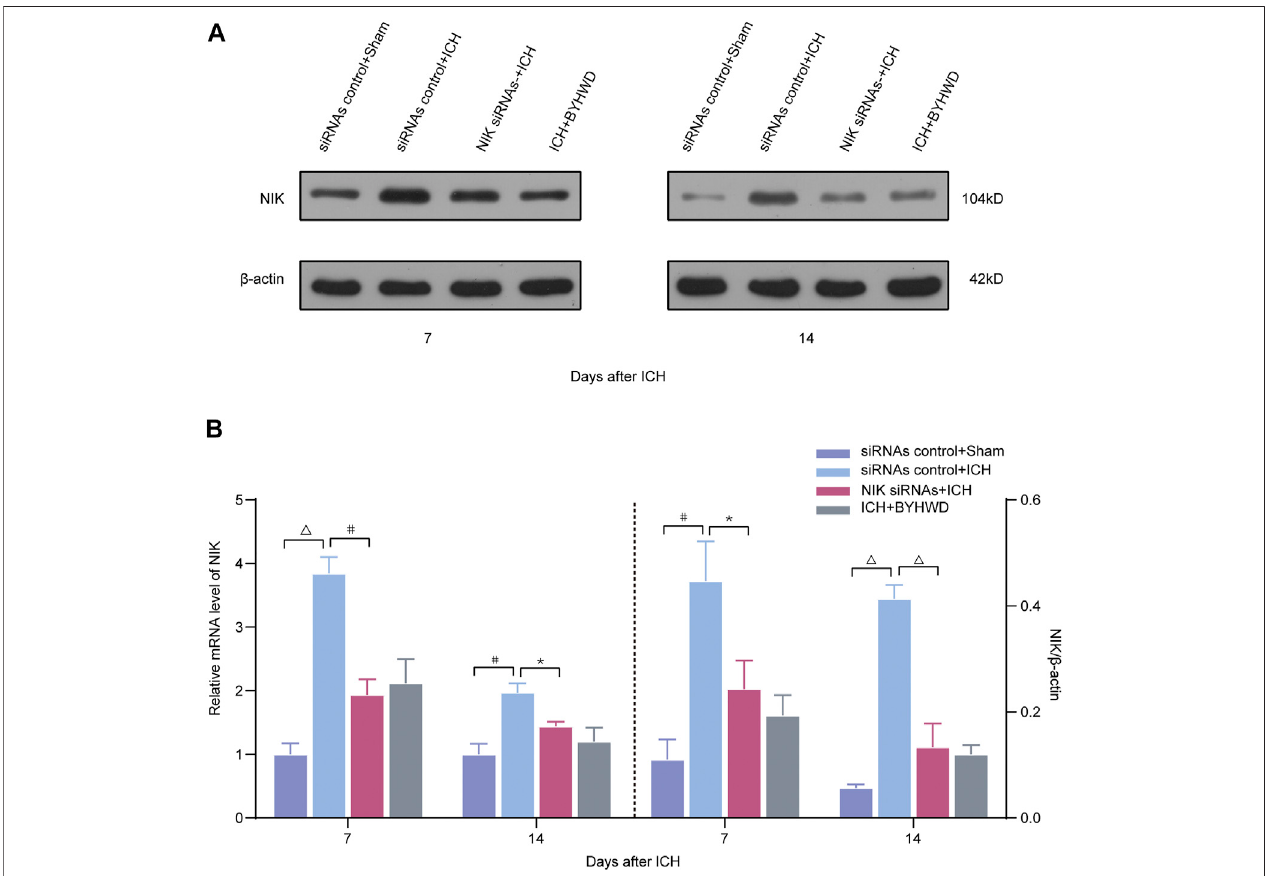
FIGURE 4 | BYHWD suppresses the expression of NIK and regulates the noncanonical NF- κ B pathway by targeting NIK protein via transfected with NIK siRNAs screening. Relative expressions of the key protein NIK were measured on days 7 and 14 transfected with NIK siRNAs or siRNAs control after ICH. (A) Representative immunoblotshowedtheeffectsofsiRNAscontrol+Sham,siRNAscontrol+ICH,NIKsiRNAs+ICH,andICH+BYHWDontheproteinlevelsofNIKattheipsilateralinjury area.TheleftsideofthedottedlineshowstherelativemRNAlevelsofNIK (B) .TherightsideofthedottedlineshowstheproteinlevelsofNIK.LevelsofNIKmRNAs were dramatically decreased in the NIK siRNAs + ICH and ICH + BYHWD group after ICH. Western blot analysis showed that the expression levels of NIK were signi fi cantlydownregulatedafter ICH.EffectofBYHWDtreatmentisconsistentwiththeeffectofblockingNIKtransfectedwithNIKsiRNAs.BYHWDsuppressed thekey protein.RelativeNIKlevelswerecalculatedbasedondensitometryanalysis.ThemeanNIKleveloftheshamgroupwasnormalizedto1.0.Dataarethemean ± SEM(n (cid:2) 3 each group); * p < 0.05, # p < 0.01, Δ P < 0.001 deemed as signi fi cant